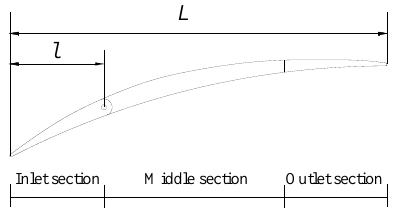
Figure 2. Schematic diagram of guide vane subsection.